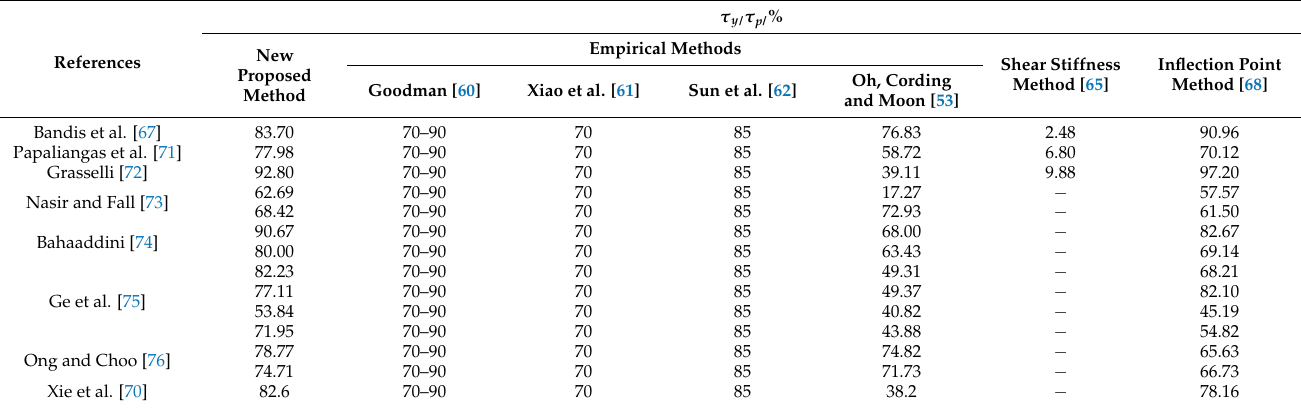
Table 1. Yield point identified by various methods.